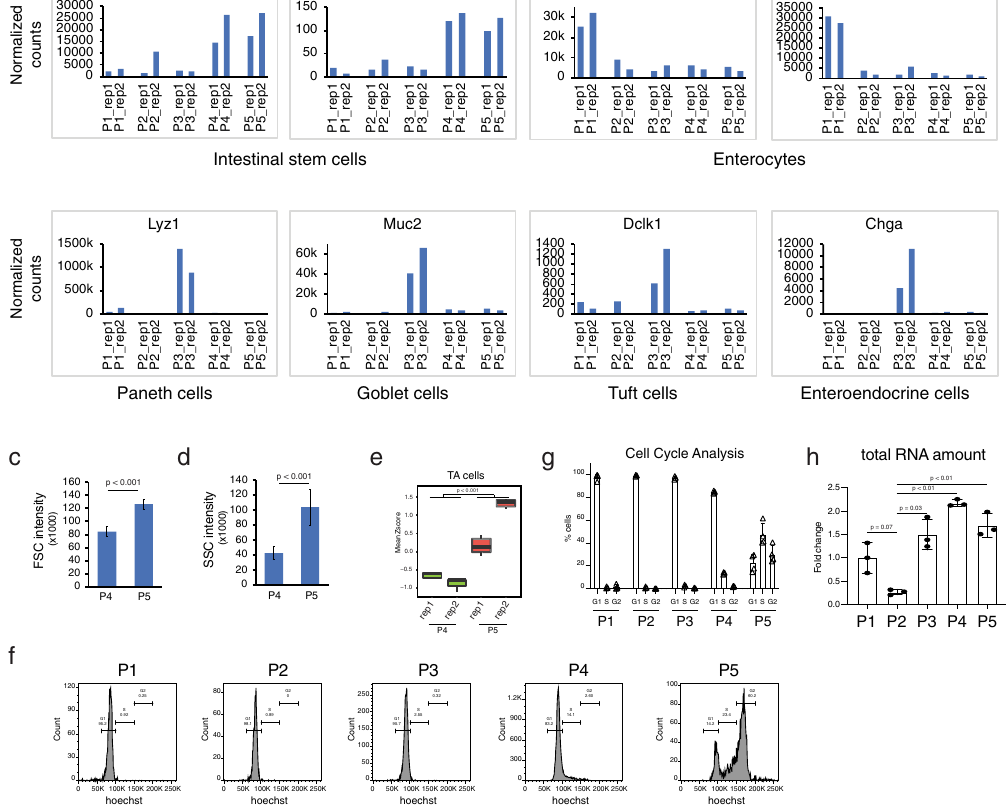
4 ° C overnight. For RNApII-pSer2 staining, small intestines of EF1a-OSCAR mice were fi xed in 4% PFA for 20min at room temperature (RT) and then treated as above. Additionally, for Ki67 staining, small intestines of EF1a-OSCAR mice were fi xed in 2% PFA at 4 ° C overnight, and washed and de-hydrated as above; after embedding in O.C.T. compound (VWR) and snap freezing in liquid nitrogen, samples were cut at 12 μ m on a Leica CM3050S cryostat, air-dried, permeabilized with PBS containing 0.1% Triton X-100 for 30 min at RT, followed by blocking with BSA 1%, 5% donkey serum in PBS containing 0.05% Triton X-100 and